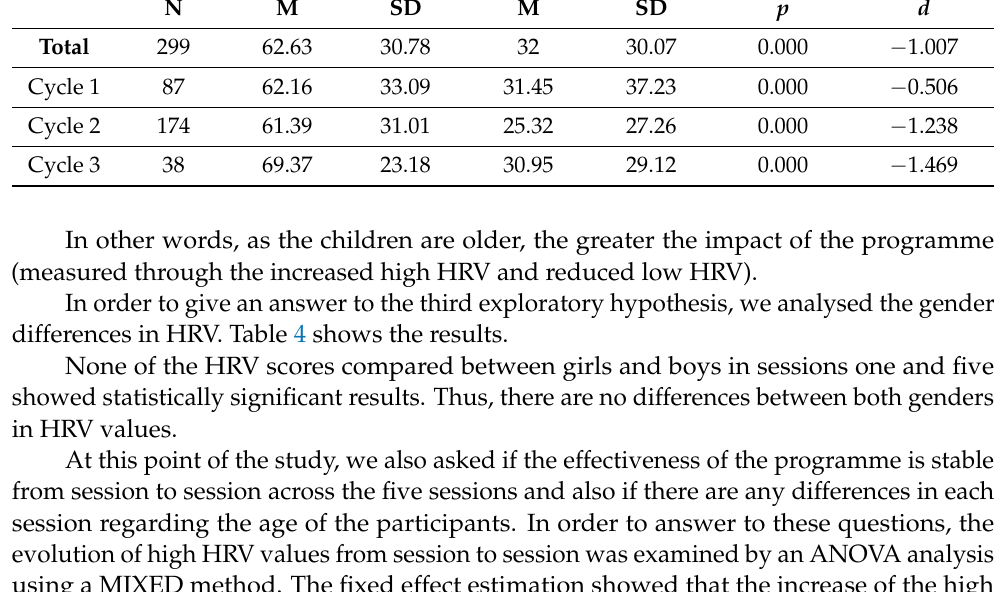
Table 3. Comparison of S1–S5 averages by low HRV and cycles.